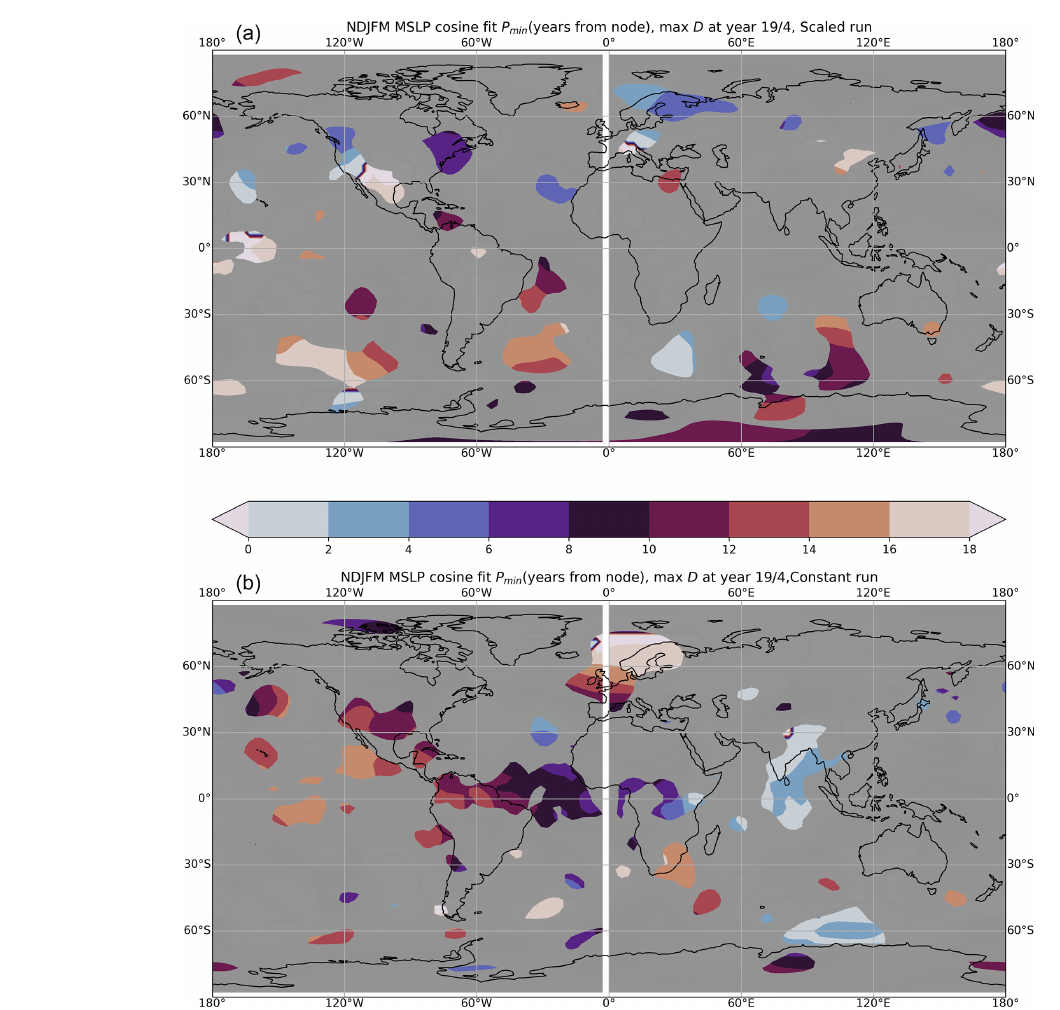
Figure 8. As Fig. 6 but for November–March (NDJFM) mean sea level pressure anomaly (hPa).